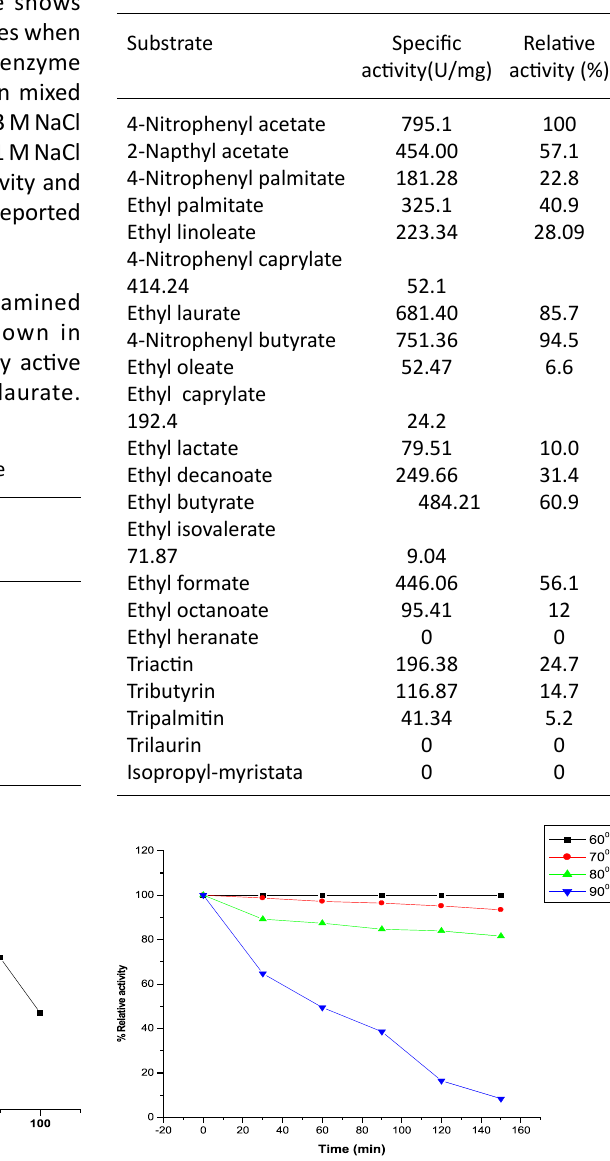
Table 5. Effect of different substrate on